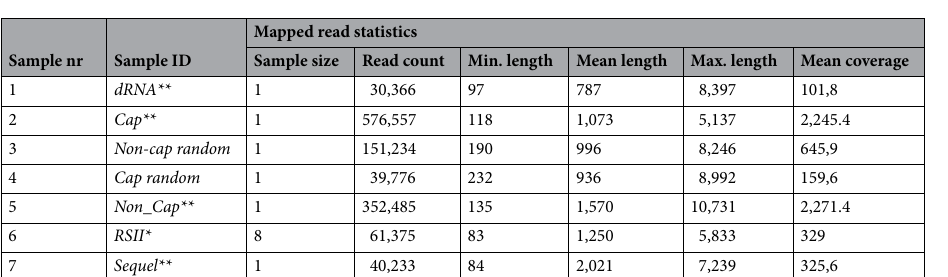
Table 1. Statistics of the reads, mapped to the Towne varS genome, according to each sample library used. The first column corresponds to the sample numbers in Fig. 1, whereas the second column corresponds to the identifier that is used throughout the study for referring to each sample. Green background corresponds to ONT, whereas blue to PacBio sequencing. The stars in the first column mean the same to as in Fig. 1.